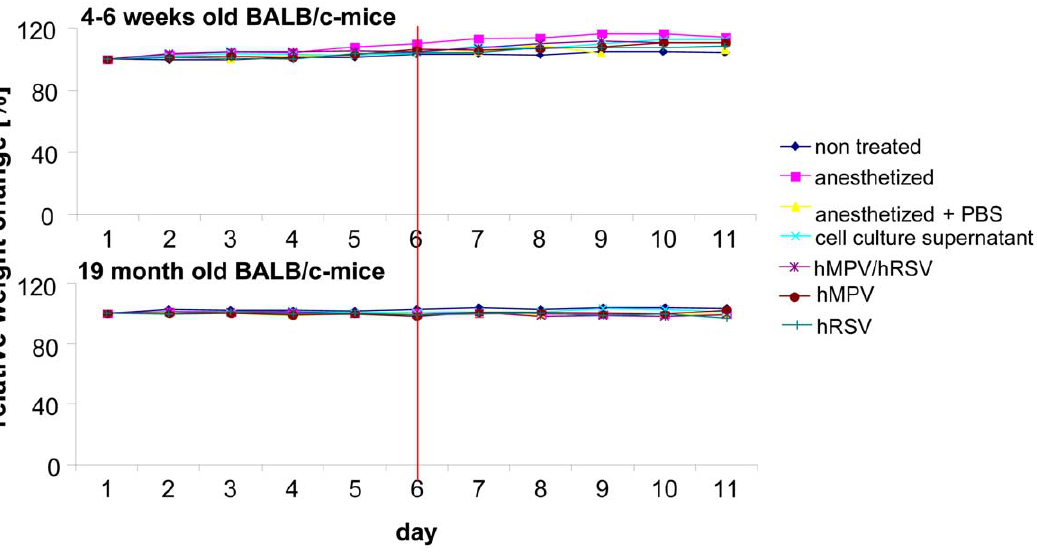
Figure 2. Weight change of infected animals. Weight change of 4–6 weeks and 19 month old BALB/c-mice before and after infection with RSV, HMPV or double infection: 4–6 weeks and 19 months old BALB/c mice were infected with 2 6 10 7 geq RSV or HMPV, or co-infected with 1 6 10 7 geq of each virus. Untreated animals, animals anesthetized and treated with cell culture supernatant or PBS or only anesthetized served as controls. Animals were weighed daily. All values were set inrelation tothe weight of the animals onday 1.The red line markstheday of infection(n=5, values are shownas mean).